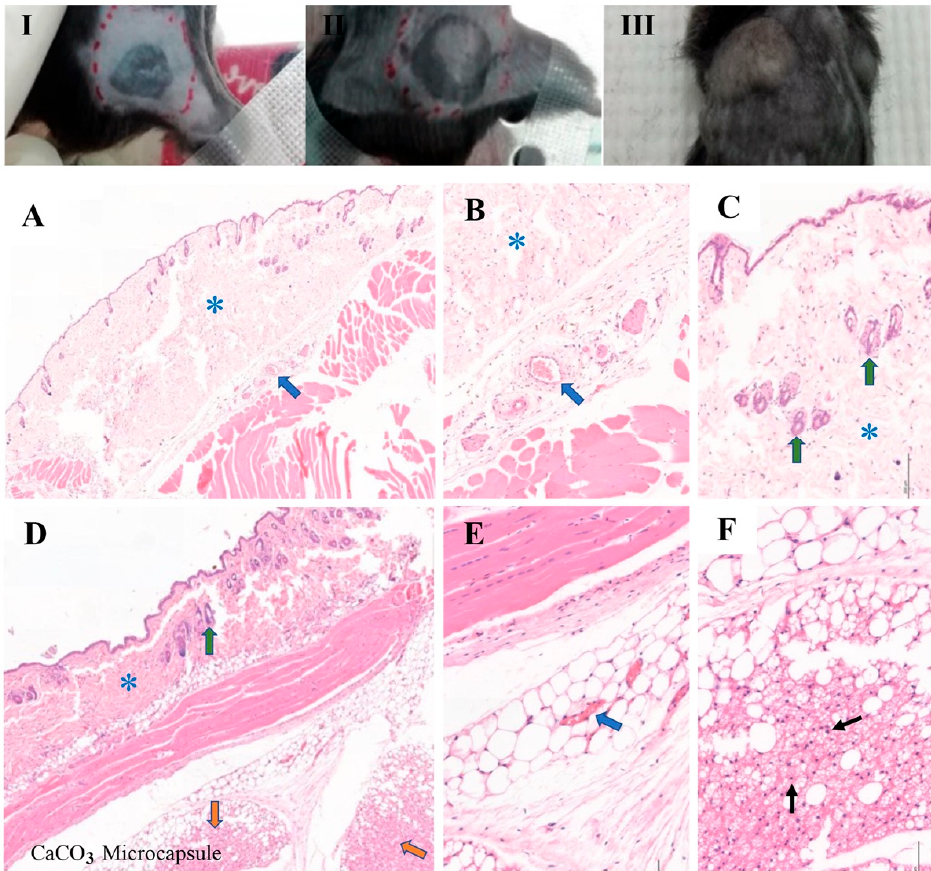
Figure 10. Subcutaneous implants of the thermosensitive calcium carbonate and 2% ( w / v ) calcium carbonate microcapsule–2% nanohydroxyapatite–10% β -glycerophosphate–4:1 ( w / w ) chitosan/collagen hydrogel in the C57BL/6NJcl mice for 4 weeks. ( I – III ) Before specimen harvesting, exhibiting normal skin and small nodules of the implant materials: ( I ) sham, ( II ) CaCO 3 , and ( III ) hydrogel groups. ( A – F ) Histological images of the ( A – C ) sham and ( D – E ) CaCO 3 groups. ( A , B , E ) At the implant/tissue interface, demonstrating infiltration of small blood vessels in the thin fibrous connective tissue that lay between the skin and muscles layers (thick blue arrows) and ( F ) lymphocytes (thin black arrows) in the implantation site of the microcapsules group. Thick green arrows indicate hair follicles in the subcutaneous tissue of skin. Blue asterisks (*) demonstrated subcutaneous tissue of skin, and orange arrows indicate the implant site of the CaCO 3 (the microcapsules cannot be seen). The thick–blue and thin black arrows suggested routine healing of the implantation sites in the sham and CaCO 3 groups. (Hematoxylin and eosin, H&E stain), ( A , D ) at 10× magnification; ( B , C , E , F ) at 20× magnification).